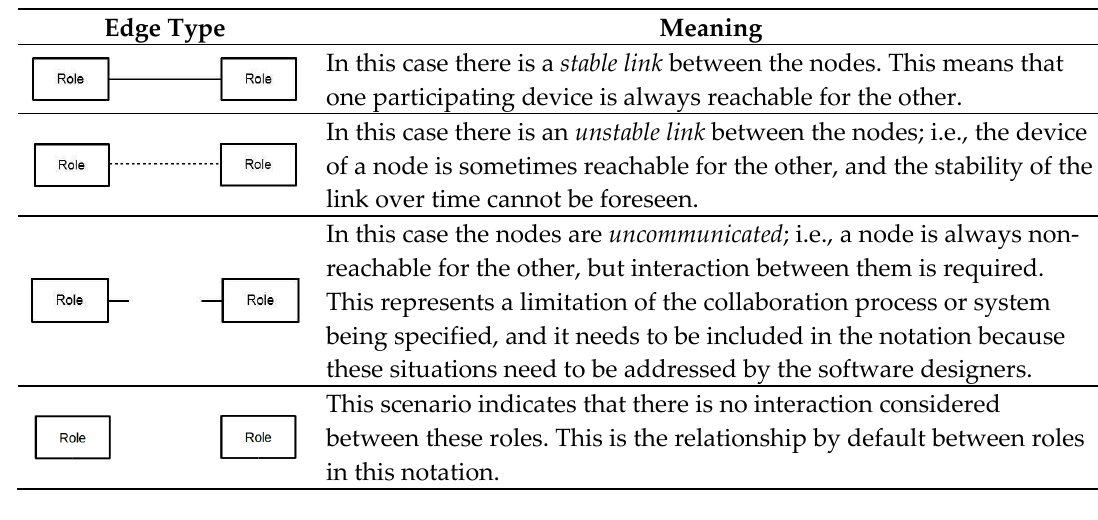
Table 3. Requirements of interaction support.